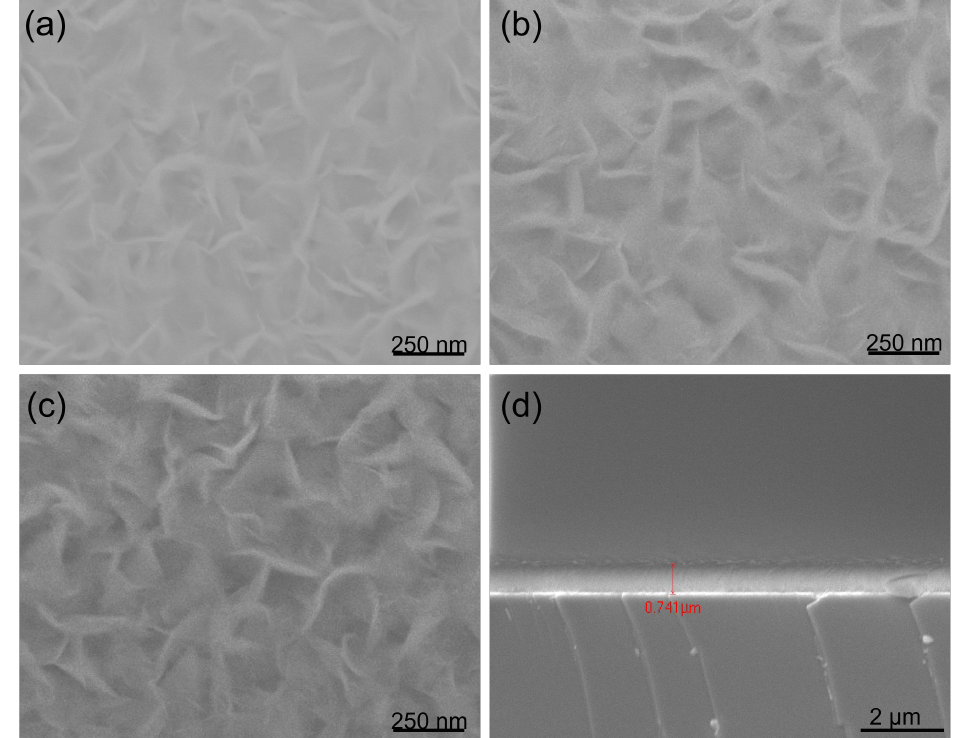
Figure 2. SEM images of BNNS films deposited on ( a ) Si wafer, ( b ) Stainless Steel, ( c ) Glass, substrates respectively under the same conditions as in Figure 1, with only the deposition duration extended from 90 to 300 min. ( d ) A cross-section of ( a